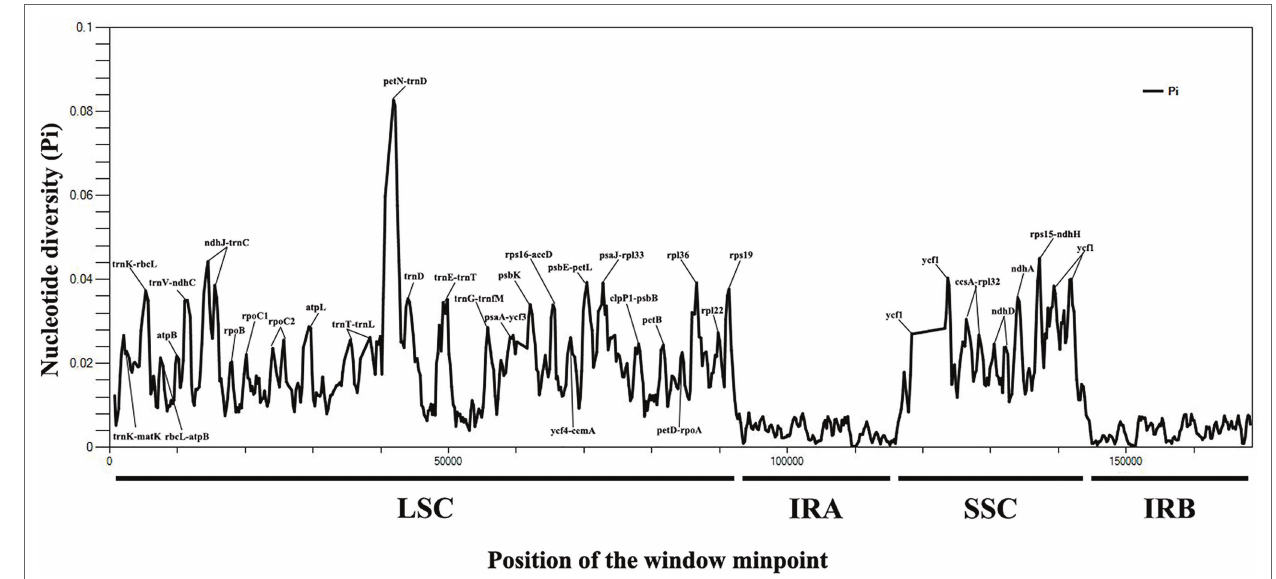
FIGURE 5 | The nucleotide diversity (Pi) value (Y-axis) with their positions (X-axis) in each window of 14 Sophora species.